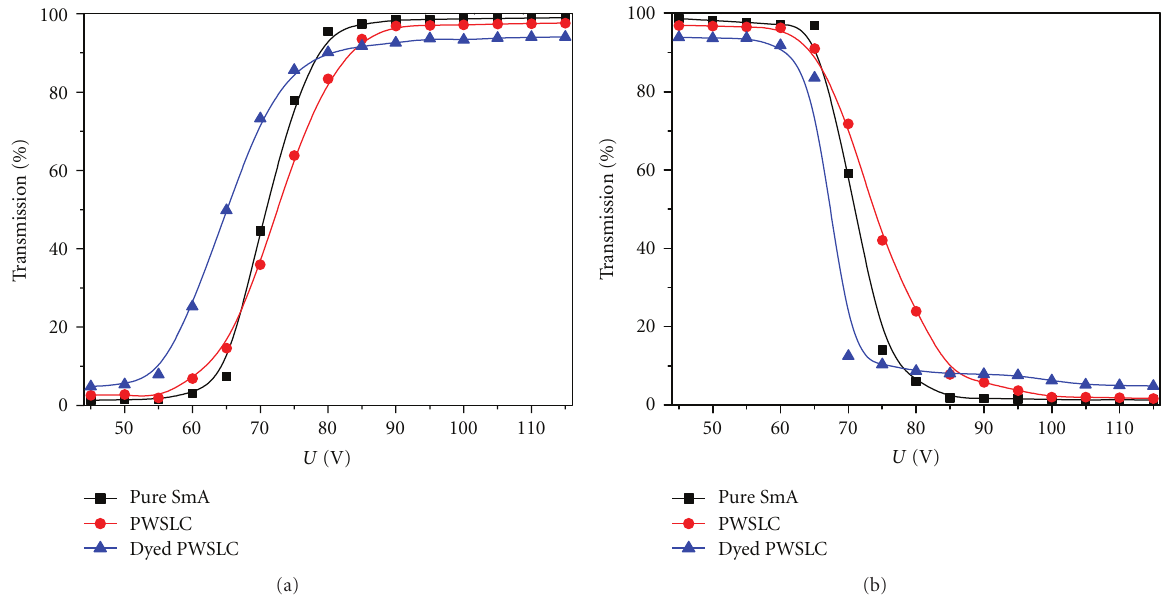
Figure 7: Static-response curves for pure SmA, cells with 2.5% monomer and with/without dye for FC-HT and EHDI transitions at (a) 5kHz and (b) 50Hz, respectively.